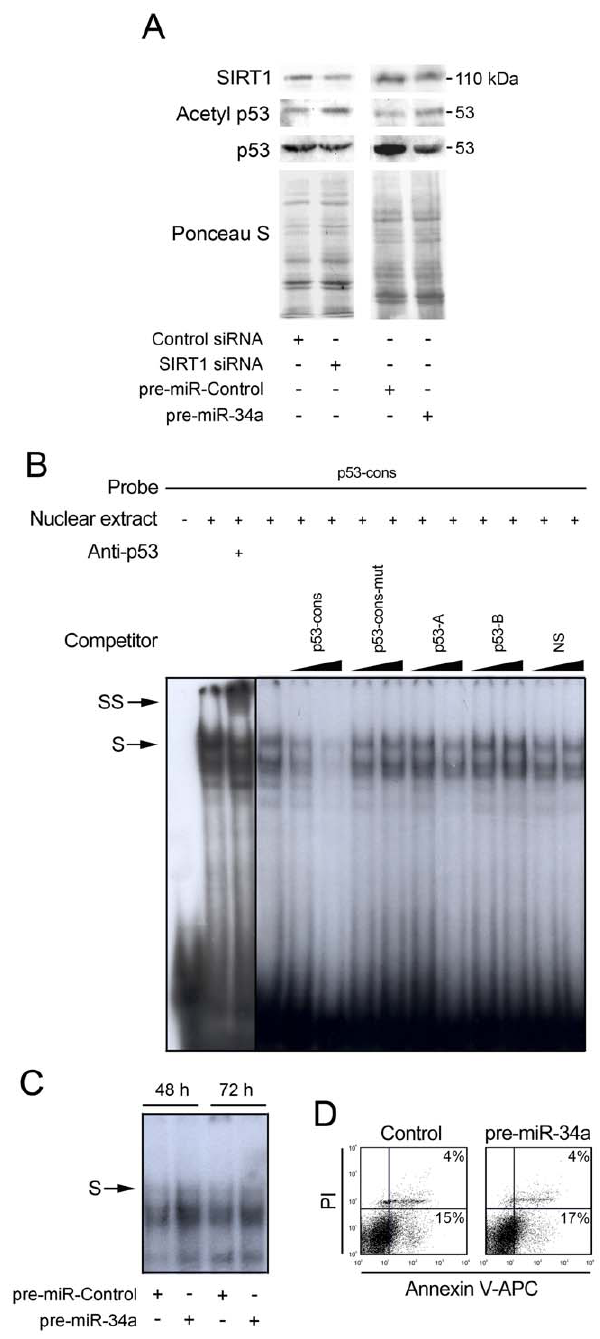
Figure 4. miR-34a overexpression increases acetylation of p53 and p53-DNA binding activity. Mouse NS cells at 3 days of differentiation were transfected with either SIRT1 siRNA or scrambled control for 48 h or with pre-miR-control or pre-miR-34a for 72 h. Cells were then collected for total and nuclear protein extraction or stained with Annexin-V-APC/PI to evaluate cell death. p53-overexpressing cells were used for supershift and competition experiments. Radio-labeled double-stranded oligonucleotide corresponding to the p53 consensus (p53 -cons) was used as a probe. A. Representative immunoblot showing increased p53 acetylation at lysine 379 after SIRT1 silencing or overexpression of miR-34a. Ponceau S was used as loading control. B. Representative EMSA showing the specificity of the complex formed with p53-cons probe. Supershift experiments were performed using an anti-p53 antibody (DO-1, Santa Cruz Biotechnology). Competition experiments were performed by adding 10- or 100-fold excess